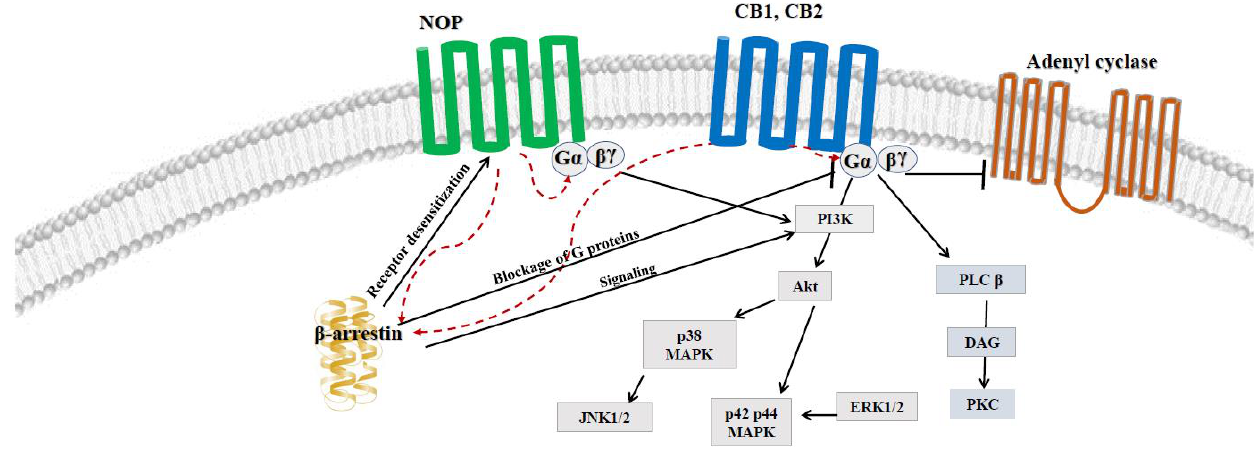
Figure 2. Shared elements of molecular pathways between NOP and CB1 and CB2 receptors. CB and NOP receptors, when activated by their ligands, influence the function of voltage-gated ion channels. Inwardly rectifying potassium channels, important in control- ling membrane potential, are either stimulated (tested in vitro on HEK293 cell line and mouse aortic myocytes) or inhibited (tested in vitro on rat ventricular myocytes) by anan- damide [50]. Nociceptin was found to induce a concentration-dependent reversible out- ward current in melanin-concentrating hormone neurons. The effect persisted in tetro- dotoxine, was reversed near the potassium equilibrium potential and displayed inward rectification, suggesting direct postsynaptic potassium channel activation [51].